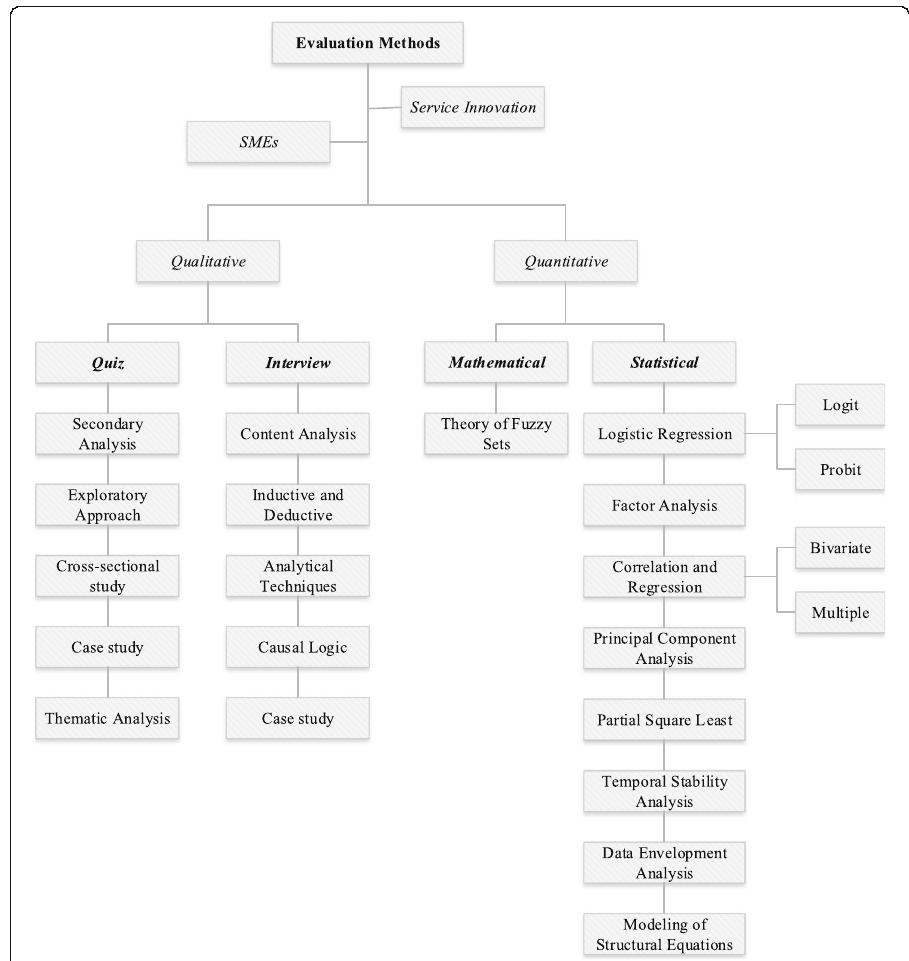
Fig. 11 Main methods used in the evaluation of service innovation in